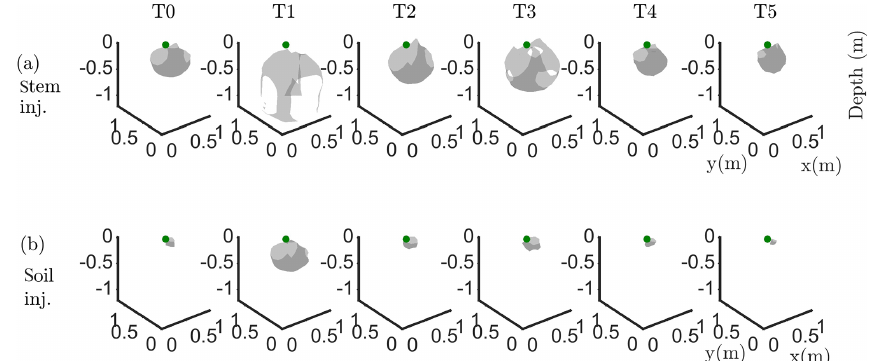
Figure 6. Iso-surface minimizing the F 1 function for plant B: during stem injection (a) and during soil injection (b) . Columns represent the six time steps from T 0 to T 5 . Green dot shows plant stem position. Threshold is defined by the misfit 25% of the normalized F 1 (value selected according to the evolution of the curve of sorted misfit F 1 , calculated for the tree injection at T 0 and kept constant for all the time